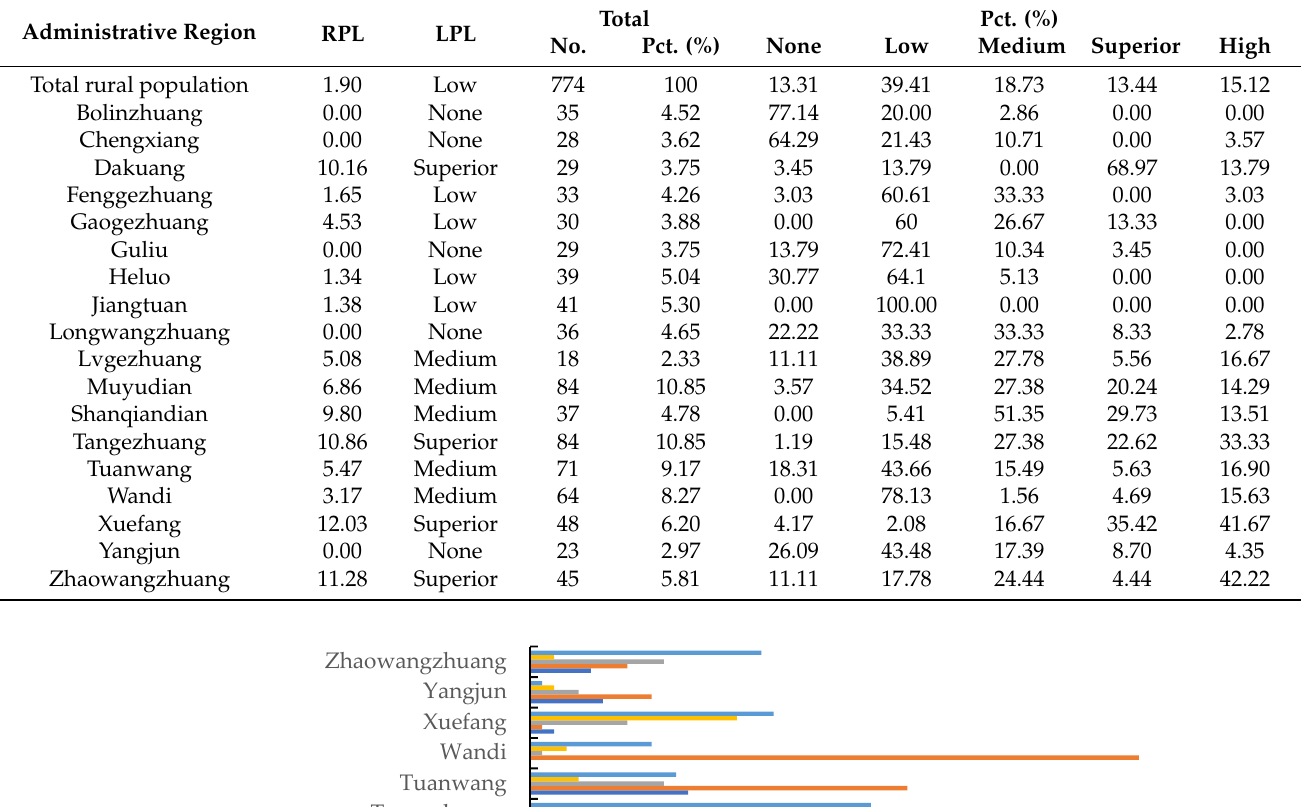
Table 4. Level of RPL in Laiyang County and its towns and subdistricts.